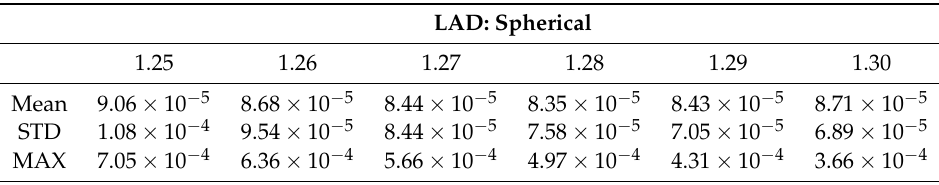
Table 2. Statistics of (cid:101) ( k ) for k = 1.25, 1.26, 1.27, 1.28, 1.29, and 1.30. STD: standard deviation. LAD: Spherical